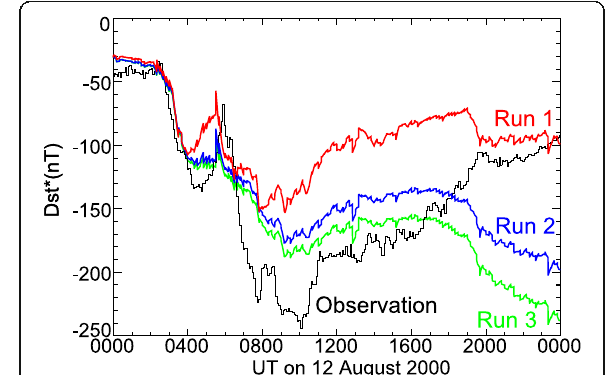
Fig. 6 Calculated Dst for run 1, run 2, and run3. Run 1 considers the charge exchange and the field-line curvature scattering. Run 2 considers the charge exchange only. Run3 considers no loss process. The black line indicates the observed one. Ebihara et al.